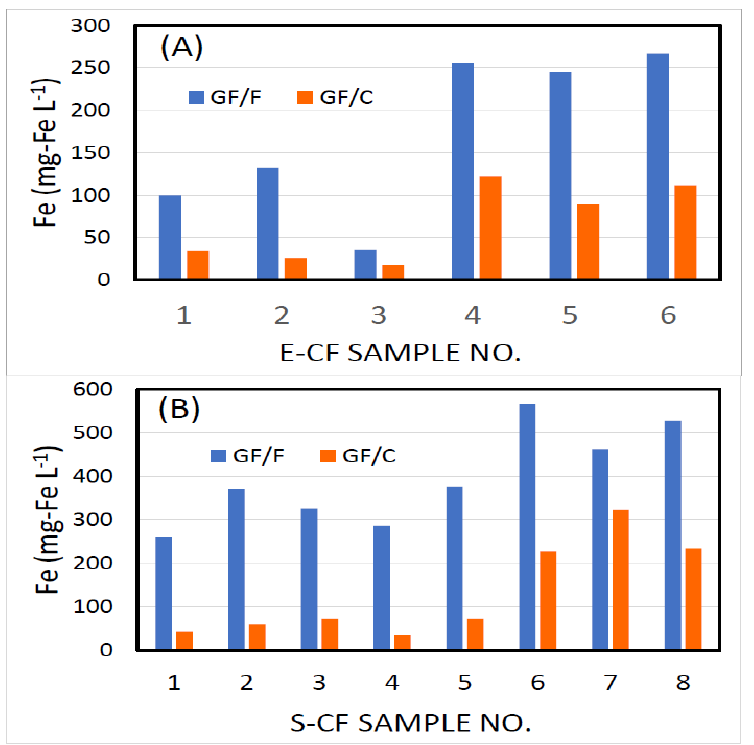
Figure 1. Comparison of the concentrations of iron fine particles retained on GF/F (>0.7 µ m) and GF/C (>1.2 µ m) filters. ( A ): in the emulsion-type cutting fluid (E-CF); ( B ): in the soluble-type cutting